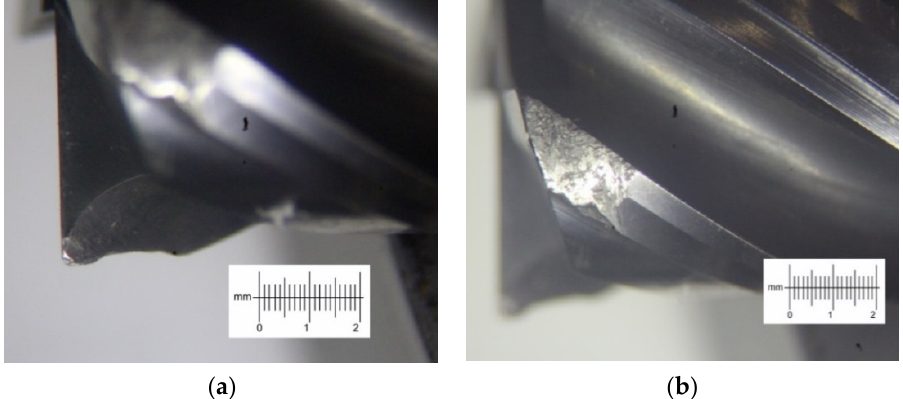
Figure 12. Photo of the wear of cutter No. 1 on the rake ( a ) and flank ( b ) surface.